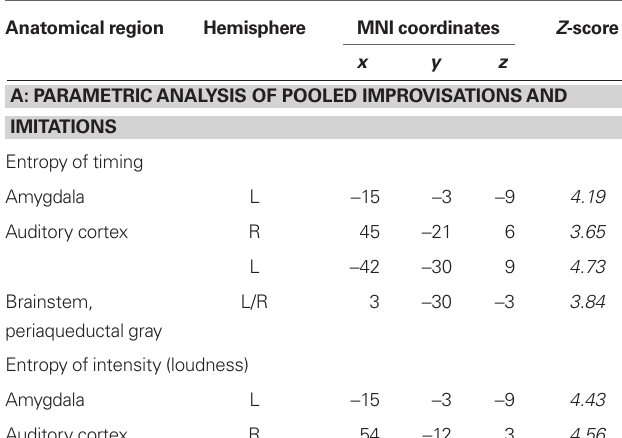
Table 4 | Activations as a function of the entropy of timing and intensity while listening to stimuli. Results are shown for parametric analyses of (A) improvisations and imitations pooled and (B) improvisations only.